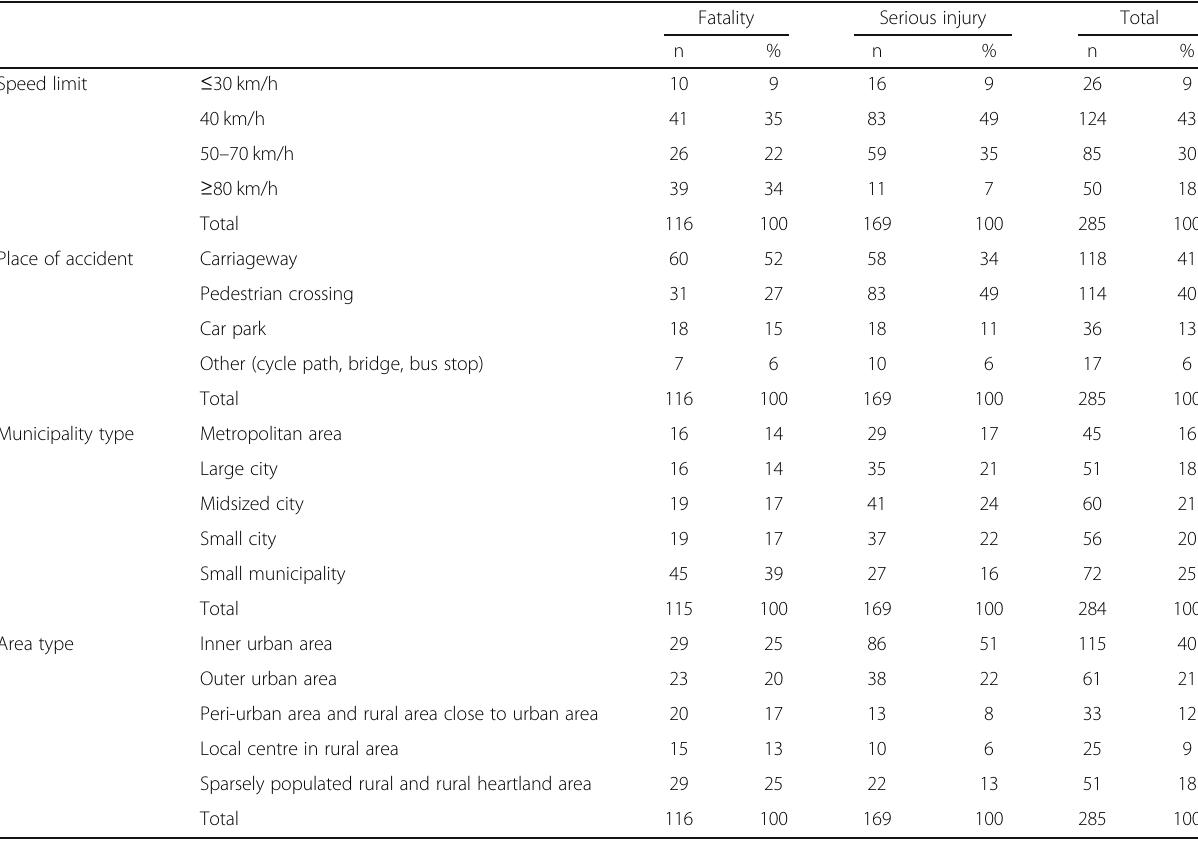
Table 2 Speed limit ( n = 285), location ( n = 285), municipality type ( n = 284), and area type ( n = 285) according to pedestrian fatality and serious